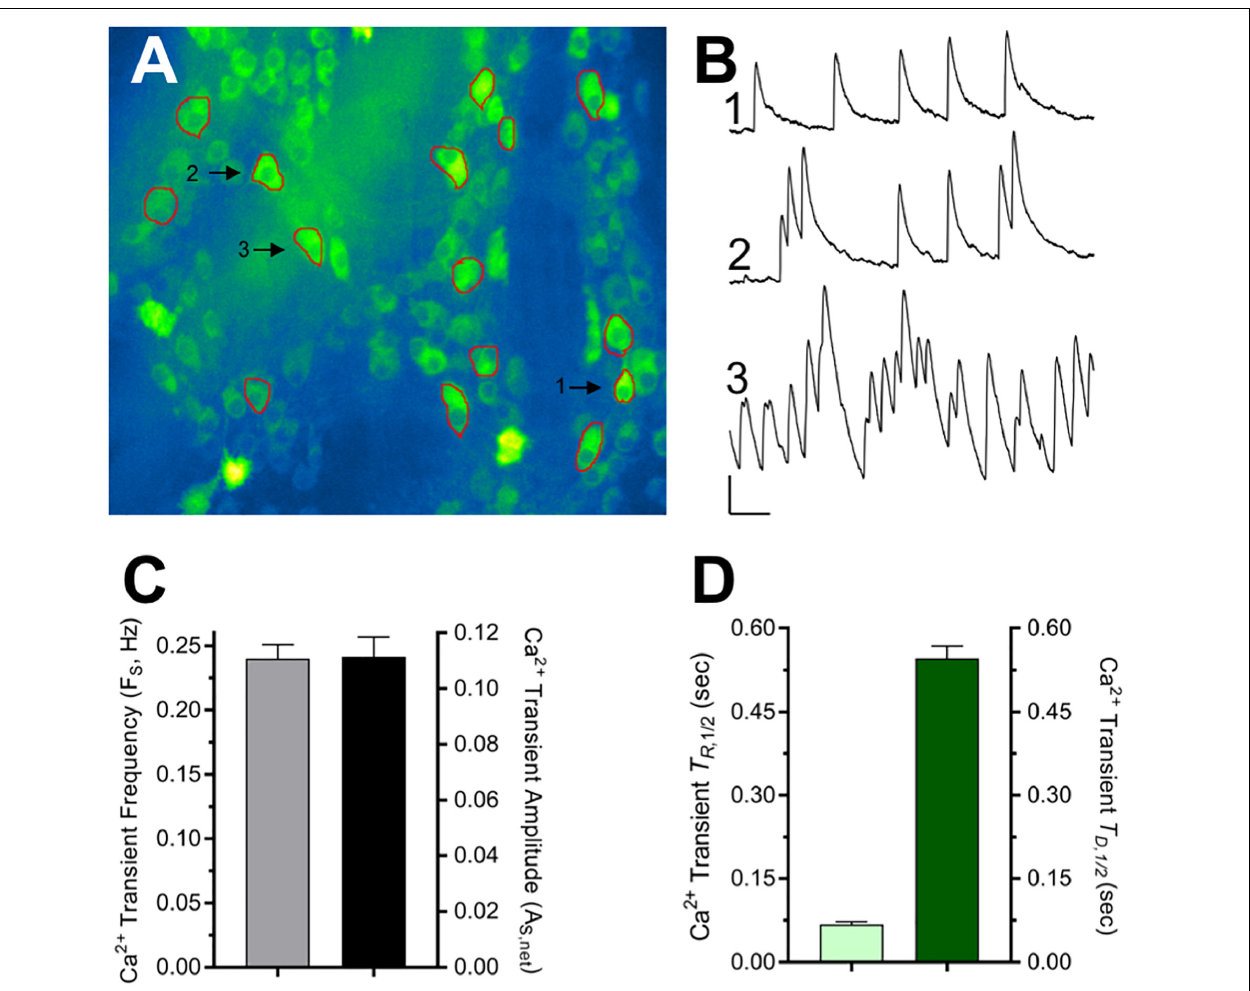
FIGURE 2 | Properties of spontaneous Ca 2 + transients displayed by cholinergic MG neurons. (A) Single frame image of ChAT + /GCaMP6f + neurons within two MG (see accompanying time-lapse Video in Supplementary Figure 1 .). ROIs drawn around 15 neuron somas chosen for analysis are indicated in red. (B) Traces show three representative types of Ca 2 + transient activity from neurons labeled 1, 2, and 3 in (A) that displayed transients that were isolated (1) moderately clustered (2), or tight clustered (3). Calibration bars: vertical = 0.1 net (cid:49) F/F 0 , horizontal = 5 s. (C) Overall characteristics of the spontaneous Ca 2 + transients. Spontaneous Ca 2 + transient frequency (F S ) was 0.240 ± 0.011 Hz ( n = 220 from N = 14 explants). Ca 2 + transient net peak amplitude (A S , Peak = Peak (cid:49) F/F 0 – Basal (cid:49) F/F 0 ) was 0.111 ± 0.007 evaluated using temporally isolated Ca 2 + transients selected at random ( n = 95; N = 7). (D) For the same neurons where A S , Peak was